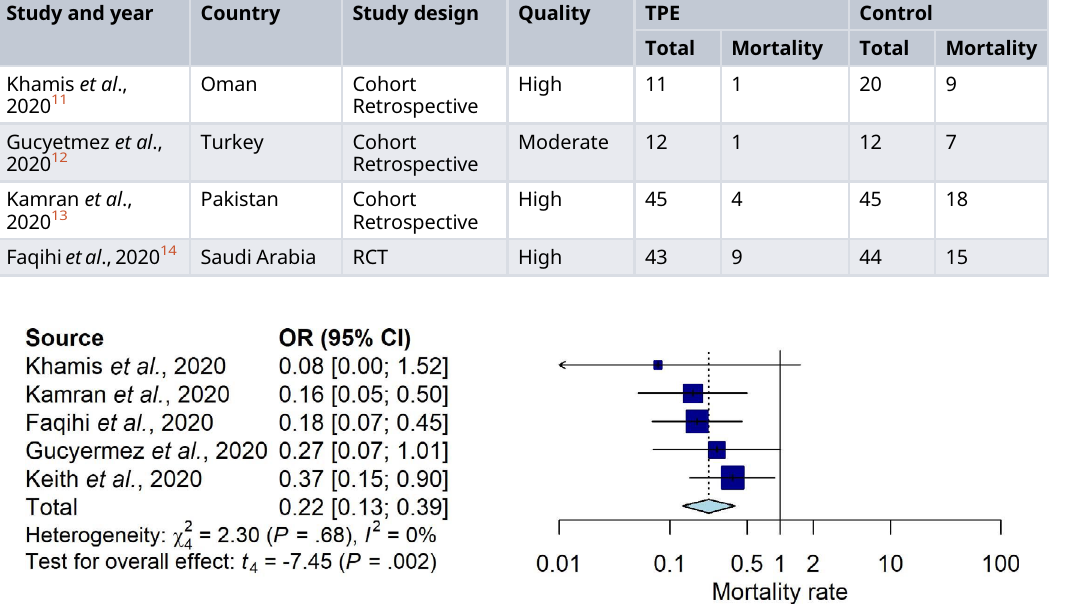
Figure 2. Forest plot of mortality rate between therapeutic plasma exchange vs control (OR: 0.2097; 95% CI: 0.0516, 0.852; p-value: 0.0382; pHet: 0.2065; pE: